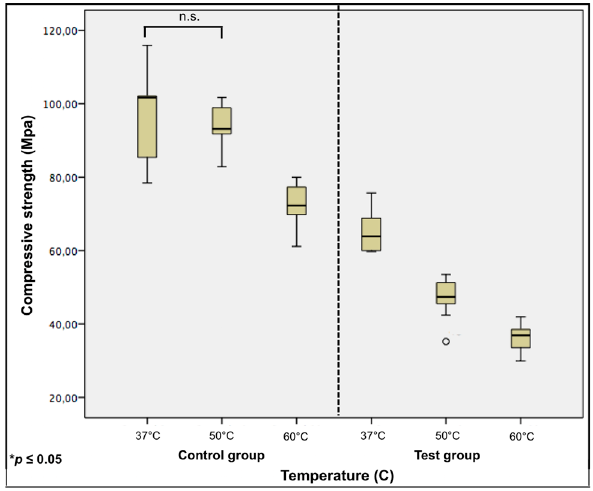
Figure 4. The compressive strength of groups under different temperatures, represented in box plots. All groups reported a statistically significant difference between one another, except the control 37 °C with control 50 °C group. Non-significant differences are connected by the horizontal lines (n.s.)